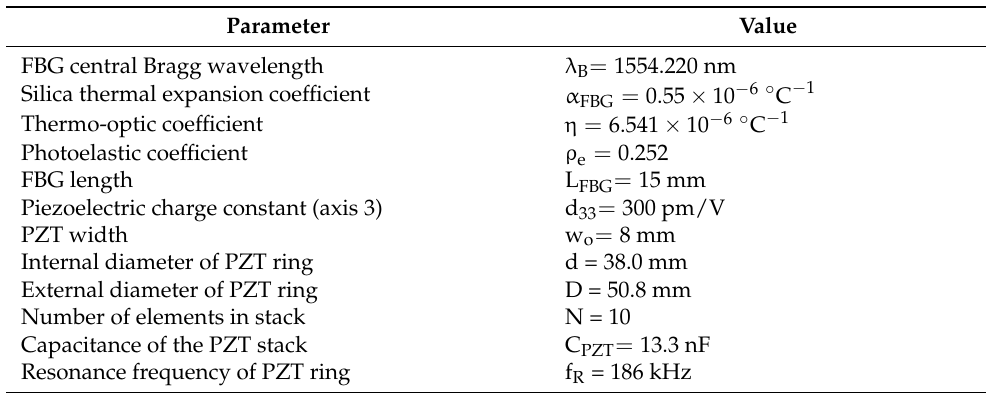
Table 1. FBG and PZT